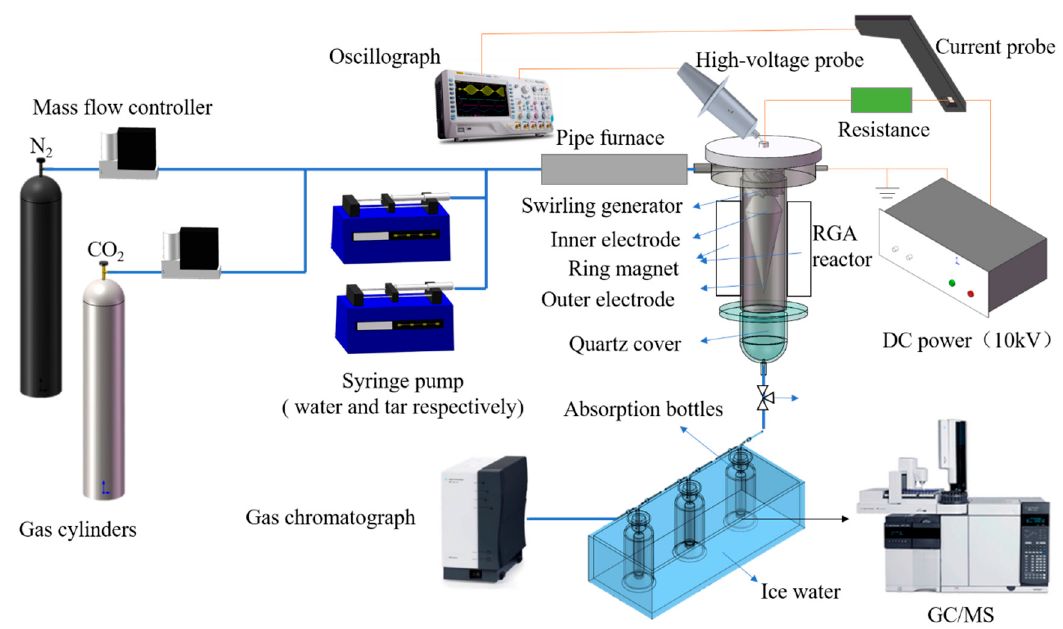
Figure 21. Schematics of the rotating gliding arc (RGA) assisted model tar destruction system.